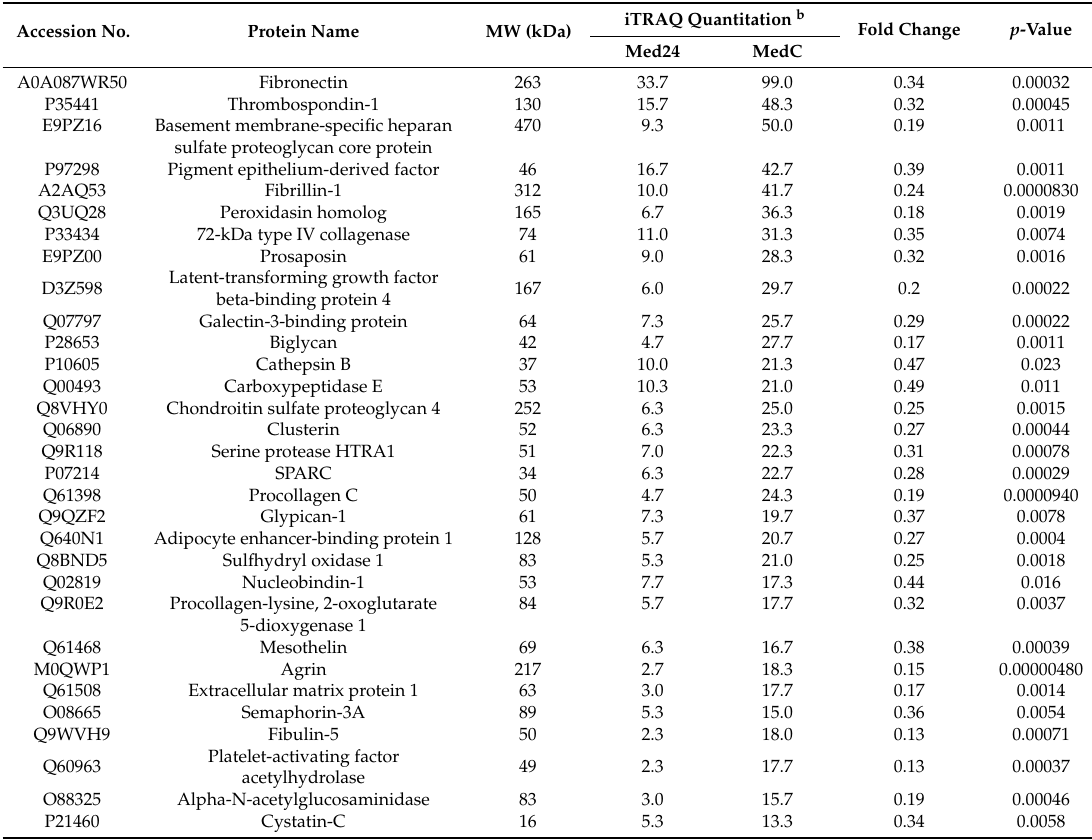
Table 2. Down-regulate proteins in the abundance group of secretomes a . a Proteins down-regulated by less than 0.5 fold by the RH2 infection are listed. b Mean of three